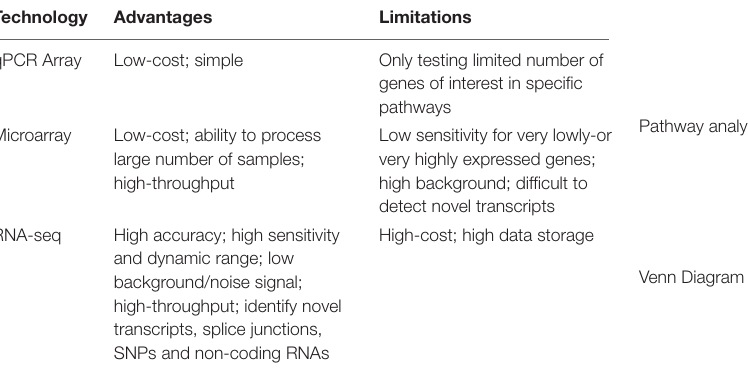
TABLE 1 | Comparisons of qPCR array, microarray and RNA-sequencing. Technology